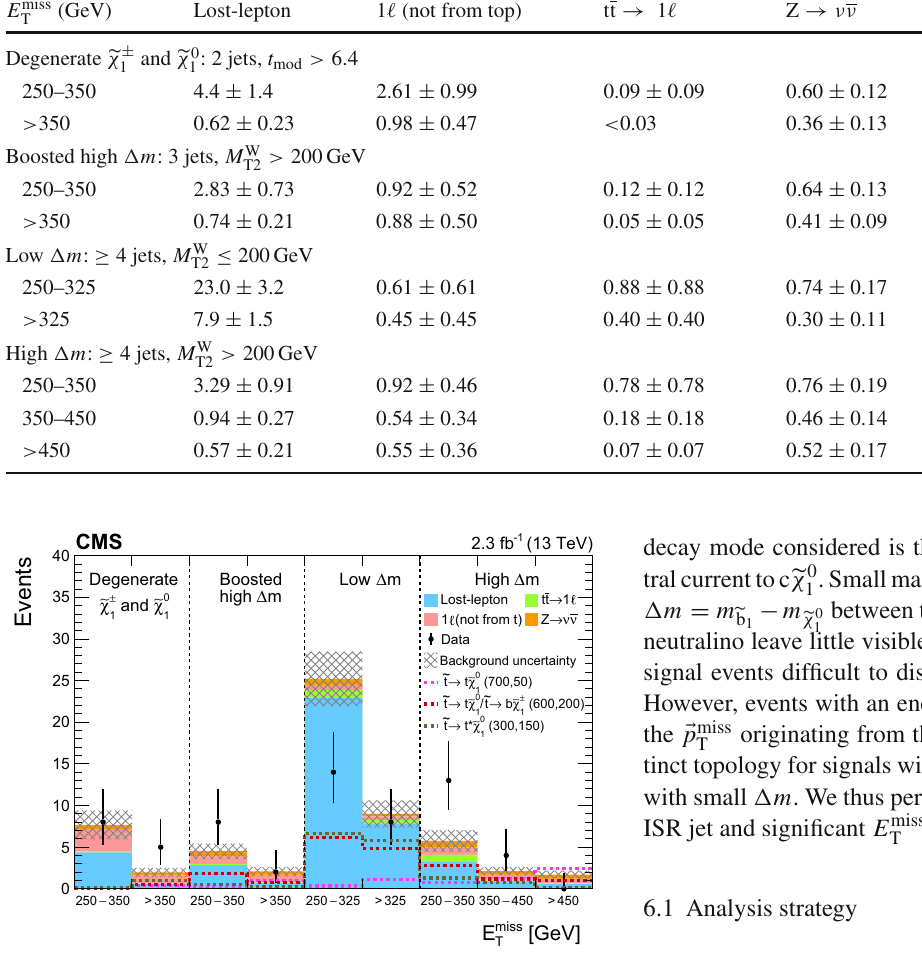
Fig. 5 Background estimates from data and simulation, together with the observed yields in the SRs of the single-lepton analysis, described in Table 3. The uncertainties, which are the quadratic sums of statistical and systematic uncertainties, are indicated by the cross-hatched areas . The SM background predictions shown do not include the effects of the maximum likelihood fit to the data. Three signal hypotheses are / (cid:2) t → b (cid:2) χ ± overlaid. The hypothesis (cid:2) t 1 → t (cid:2) χ 0 has branching fractions 1 1 1 → t (cid:2) χ 0 ) = B ( (cid:2) t → b (cid:2) χ ± ) = 0 . B ( (cid:2) t 1 1 1 1